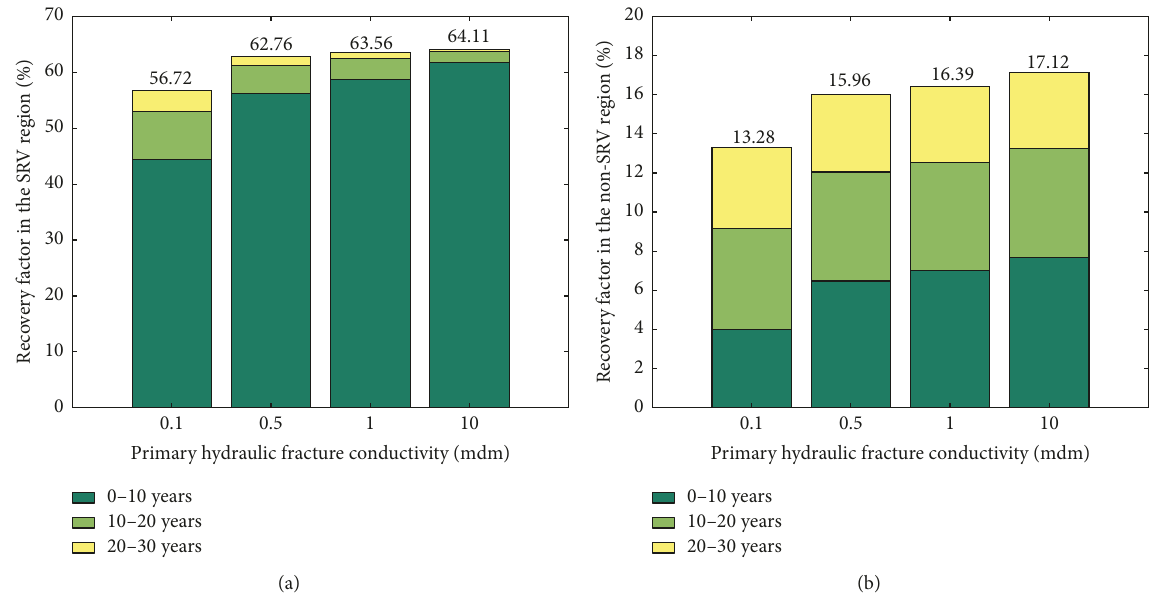
Figure 13: The effect of primary hydraulic fracture conductivity on the recovery factor: (a) SRV and (b) non-SRV regions.